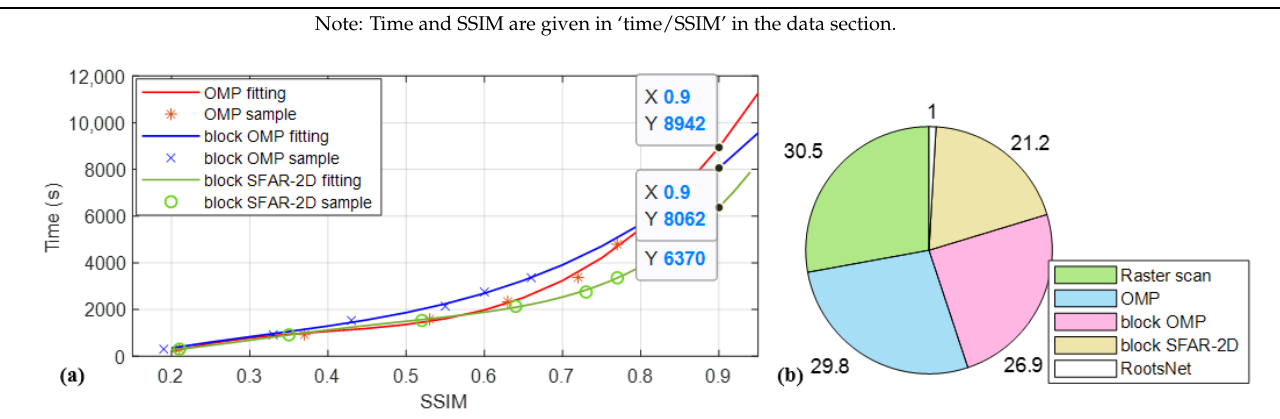
Figure 12. Average time vs. imaging quality. ( a ) The estimated time for traditional iterative reconstruction methods when reaching 0.9 of SSIM by fitting; ( b ) Normalized time consumption of different methods when reaching 0.9 of SSIM.